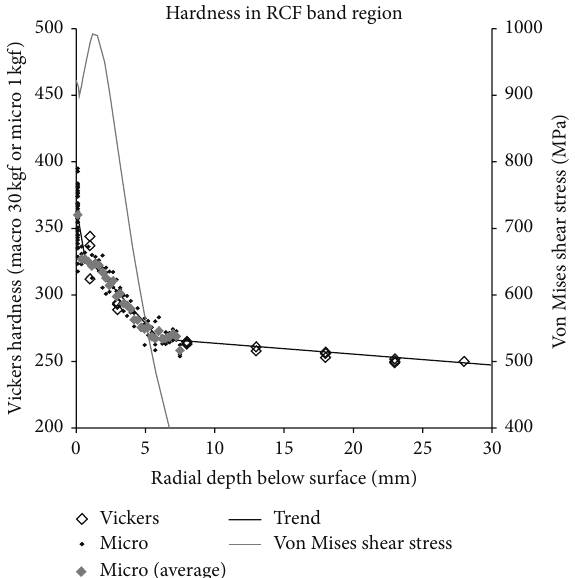
Figure 23: RCF band: relationship between predicted maximum von Mises shear stress and hardness in worn